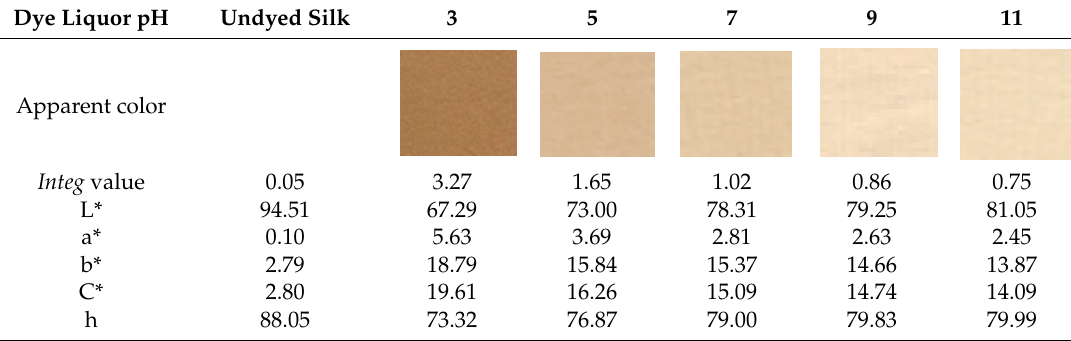
Table 2. The color parameters of dyed silk fabrics based on laccase-catalyzed oxidative polymerization for tea polyphenols.